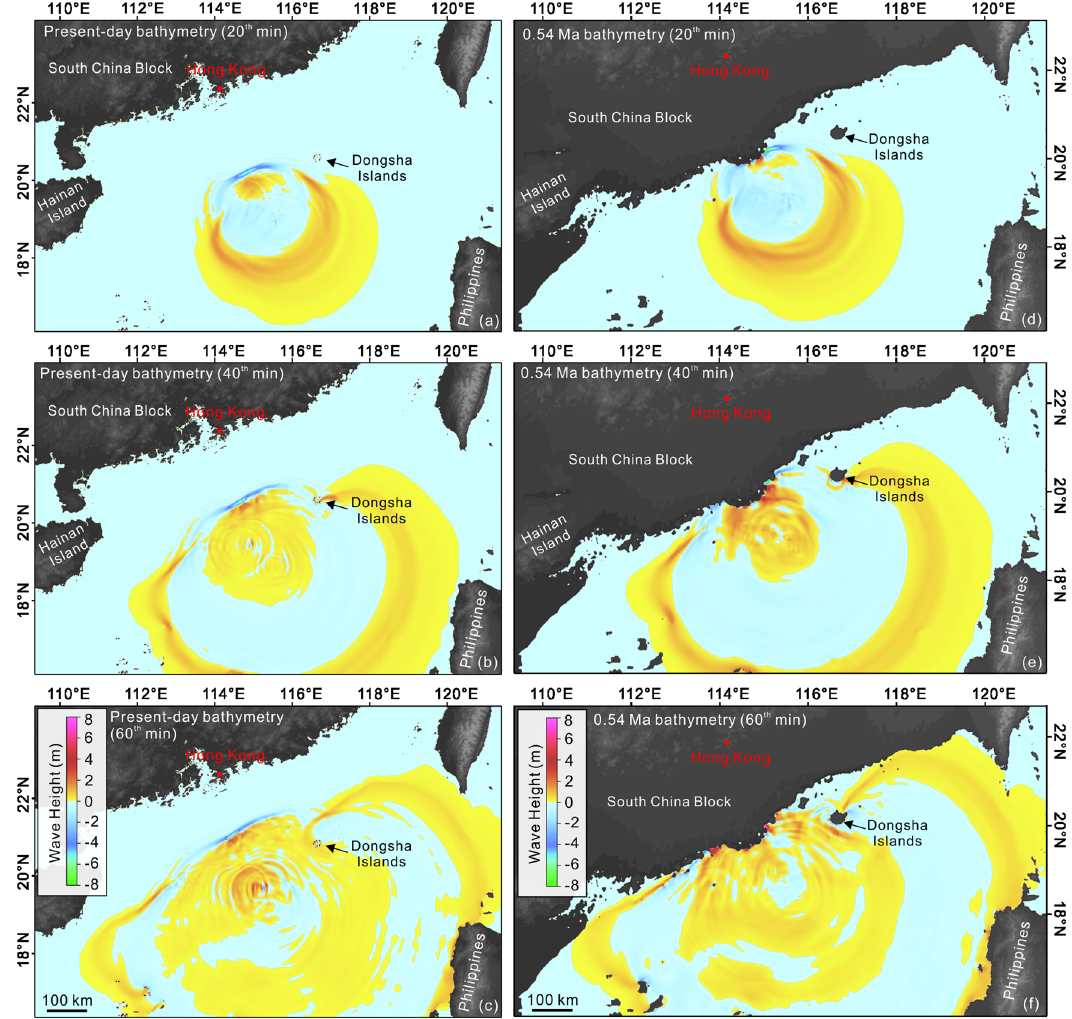
Fig. 6 Tsunami-wave propagation. a – c Tsunami-wave propagation at 20, 40, and 60 min bearing in mind the present-day bathymetry and shoreline position; d – f Tsunami-wave propagation at 20, 40, and 60 min considering the 0.54 Ma bathymetry and shoreline position. Tsunami waves propagate from the region of slope failure and rapidly propagate to the southeast. They are comparatively slower when propagating to the northwest. Bathymetry in fl uences tsunami-wave propagation and its resulting impact on coastal